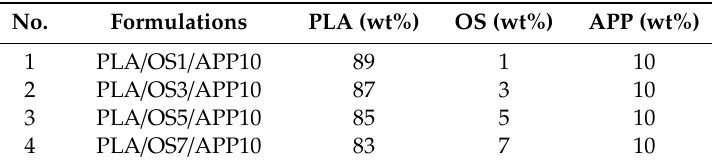
Table 1. Additives Composition in PLA / OS / APP